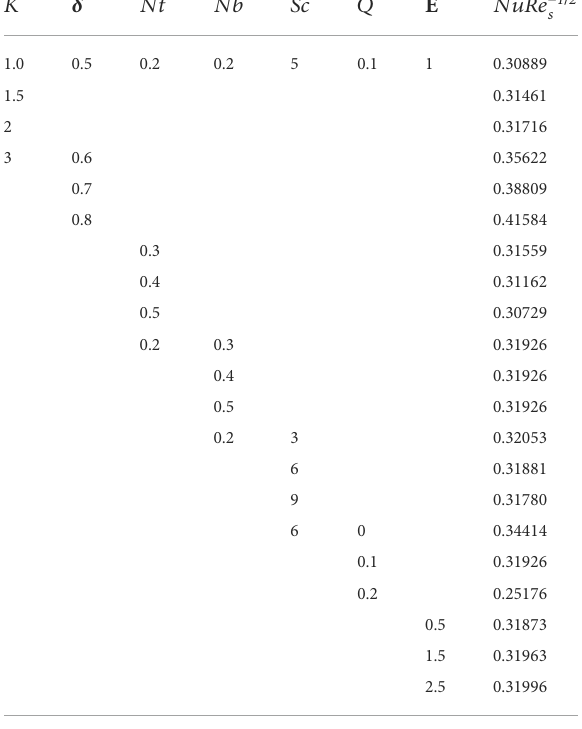
TABLE 3 Local Nusselt number for various values K , δ , Nt , Nb , Sc , E , andQ